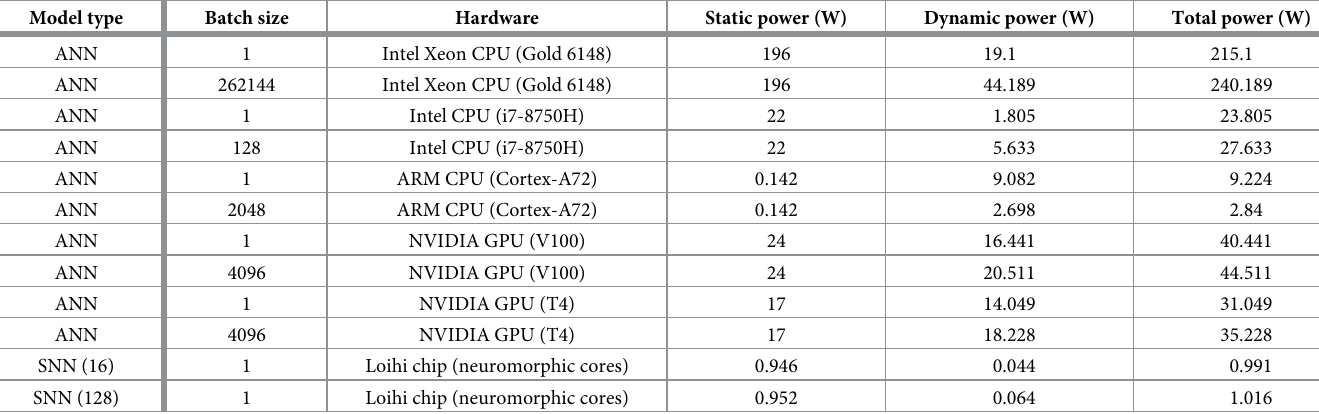
Table 4. Inference power consumption.